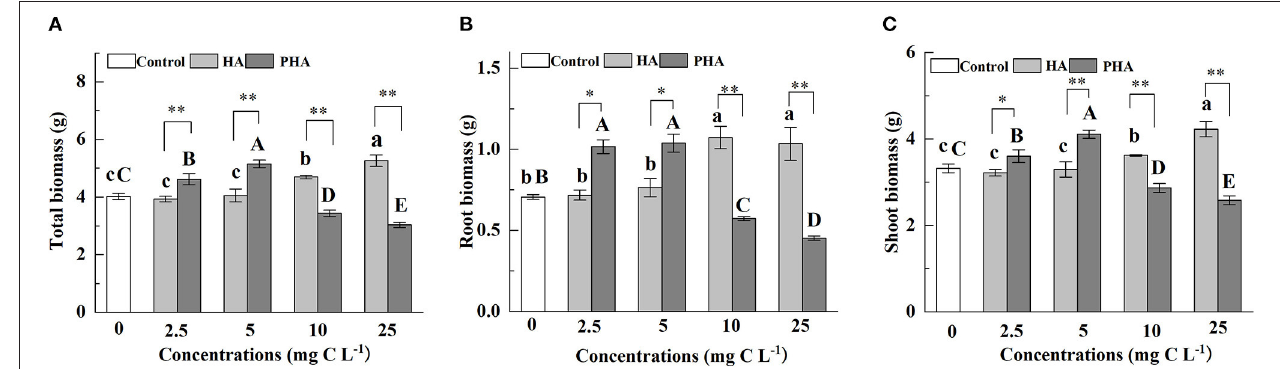
FIGURE 1 | Effects of 2.5–25mg C L − 1 of HA or PHA on the (A) total dry biomass, (B) root biomass, and (C) shoot biomass. Error bars represent standard deviations ( n = 3). Different lowercase letters above columns indicate significant differences between HA and control treatments, while different capital letters above columns indicate significant differences between PHA and control treatments at P < 0.05, as determined by the LSD test. Significant differences between HA and PHA treatments at equivalent carbon concentrations were compared with two independent sample t -tests, * P < 0.05; ** P < 0.01.